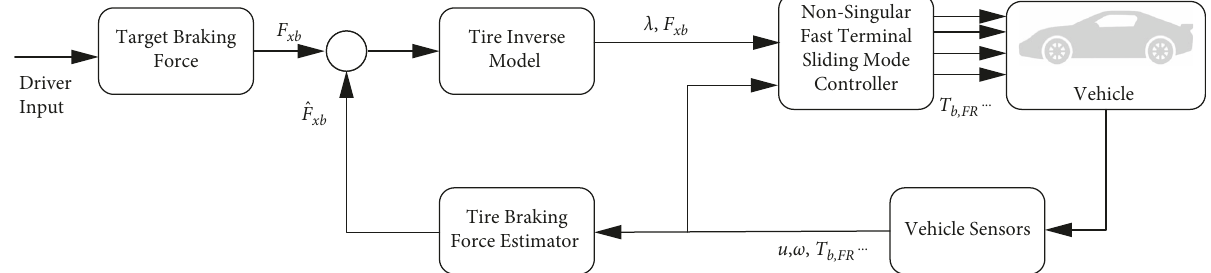
Figure 3: Schematic of direct braking force antilock braking system